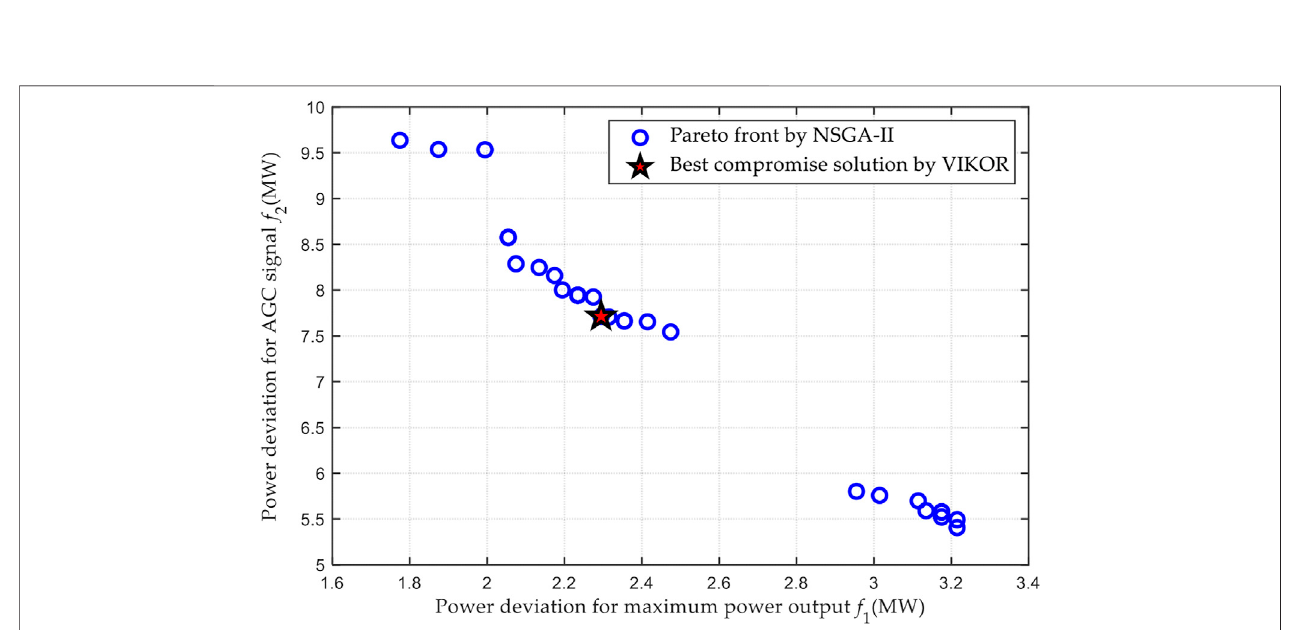
Frontiers in Energy Research |